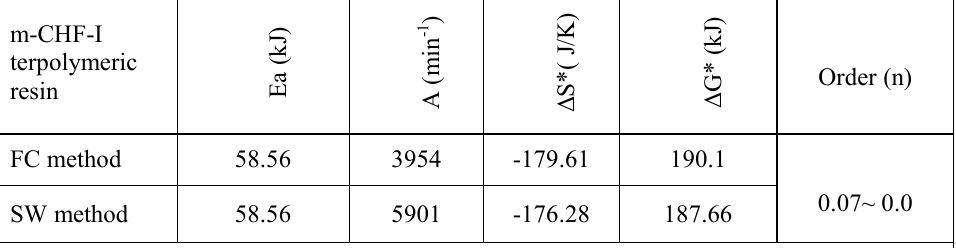
Table 4: Thermokinetic parameters of m-CHF-I terpoymeric resin.